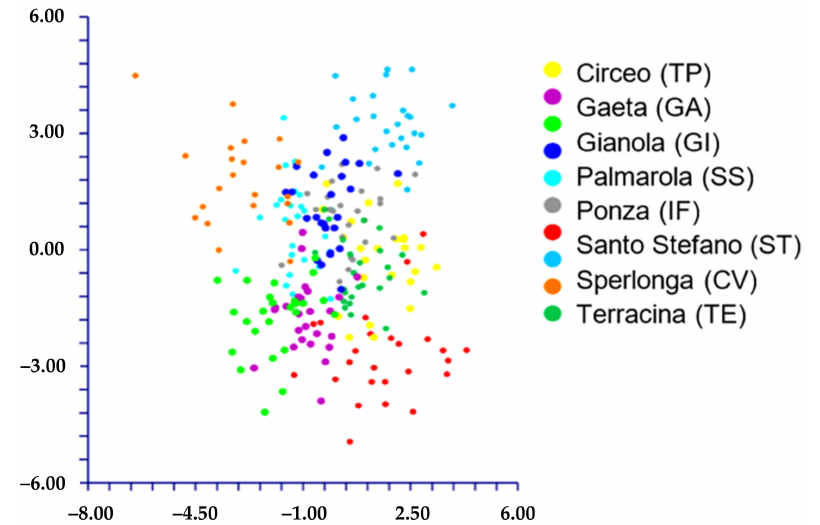
Figure 6. DA (first ( x axis) vs. second ( y axis) components) performed on groups classified using the localities’